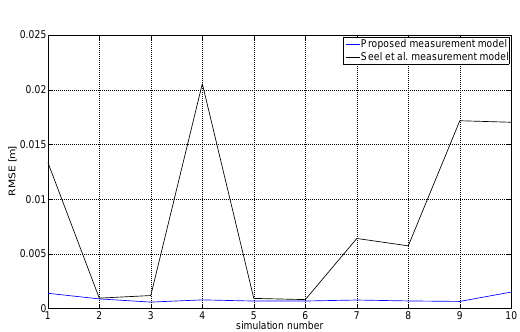
Figure 4: RMSE for 10 different IMU mounting orientations when applying the measurement model defined in (13) to type 2 move- ments.